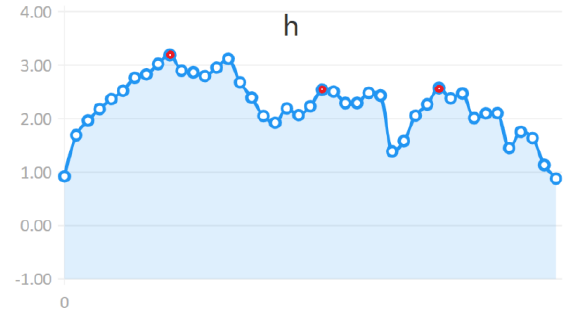
Figure 7. Red dots correspond to the peak vertical dimensions of anatomical occlusal surface on